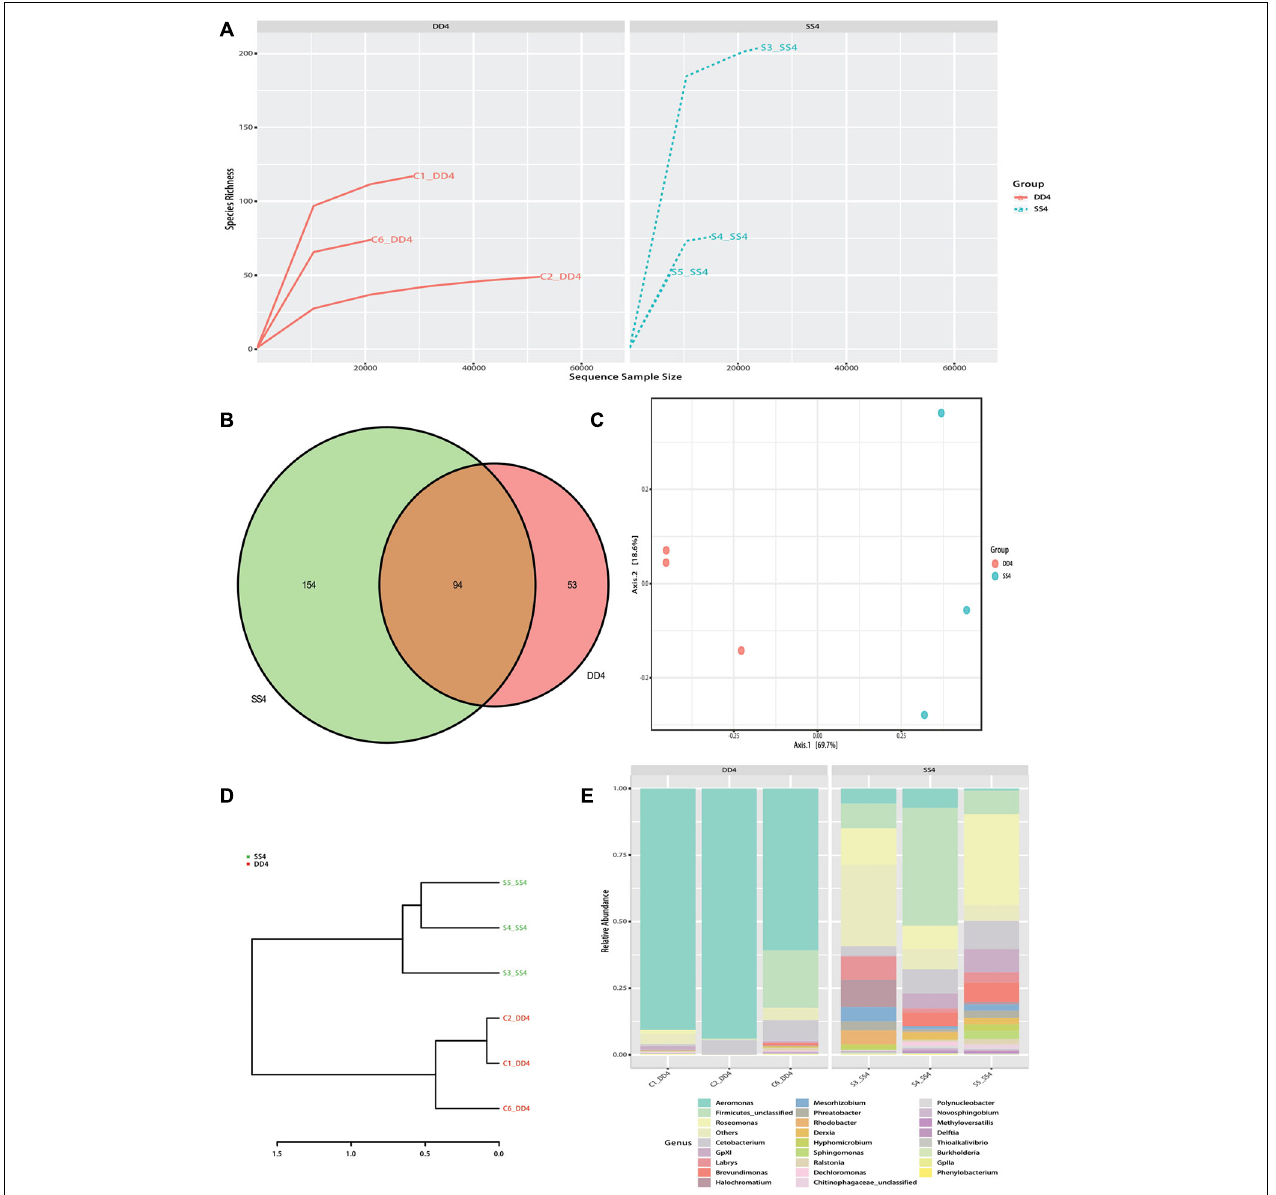
FIGURE 2 | Bacterial composition analysis of the selection (Huanghe carp new strain 4th generation) and control lines. (A) Rank abundance curves for all samples’ gut bacteria communities. (B) Venn diagram showing gut bacteria of selection and control lines. (C) PCA plot of gut bacterial communities between the selection and control lines. (D) UPGMA tree based on weighted UniFrac distances. (E) Bar chart of relative bacterial abundance at genus level in selection and control lines. DD4 refers to the control group, and SS4 refers to the selection